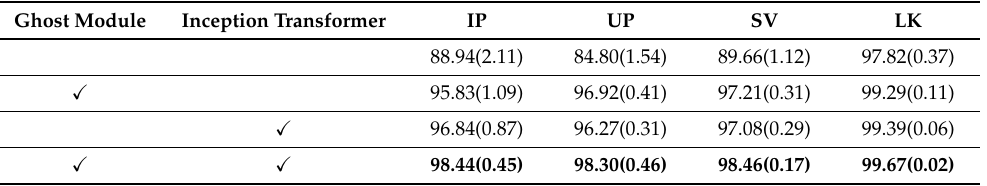
Table 10. Analysis of the effect of Ghost module and Inception Transformer to affect the OA of IFormer on HSI dataset. (cid:88) means use of the